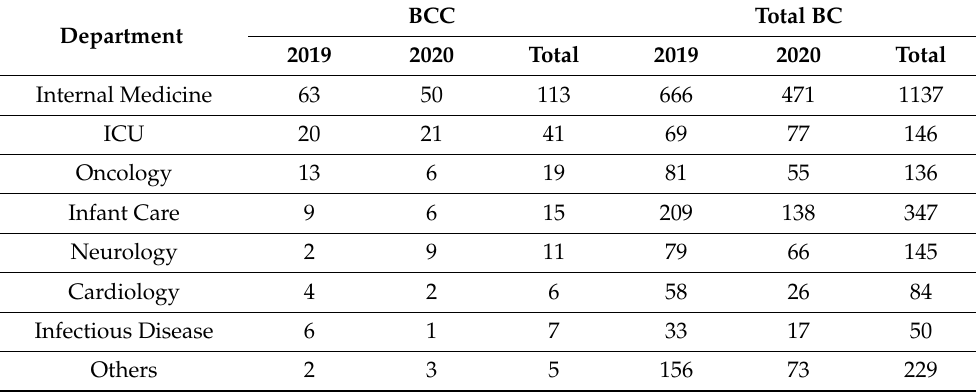
Table 2. Number of BCC versus total BC samples among various hospital departments in 2019 and 2020.